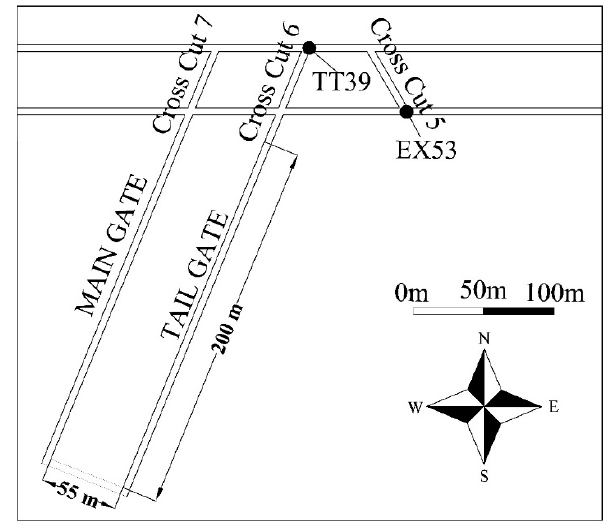
Figure 2. Trial panel and location map of displacement monitoring devices (TT 39 and EX53).